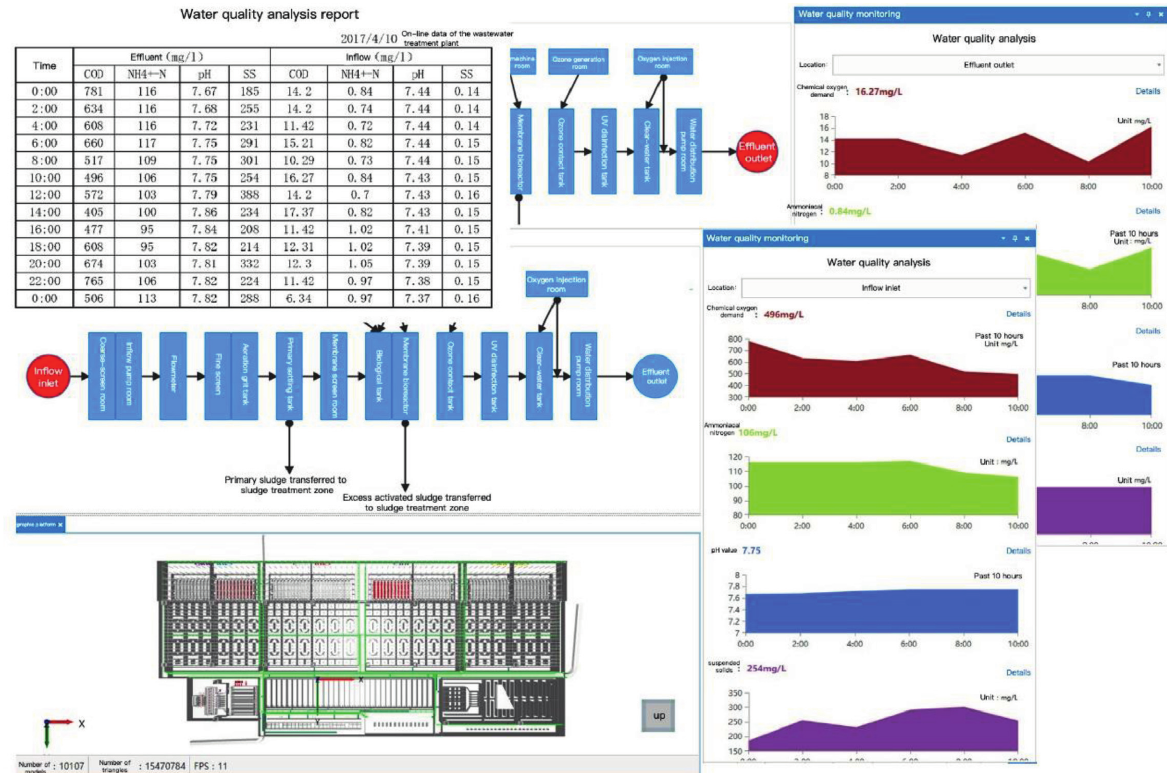
Figure 6: Effluent water-quality monitoring and report